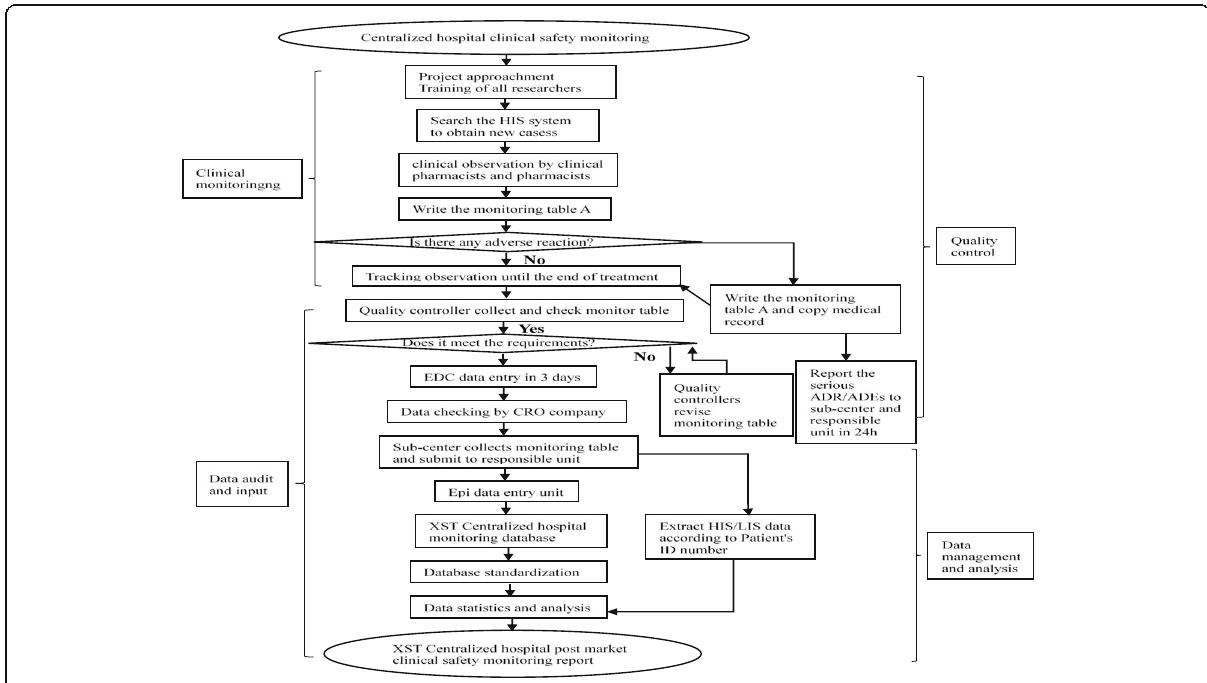
Fig. 1 Post-marketing safety re-evaluation of XSTI